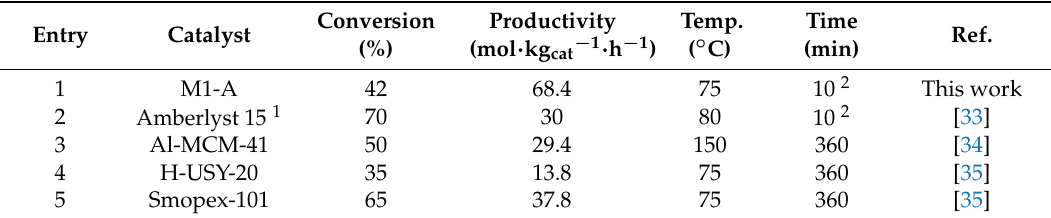
Table 4. Comparison of acetic acid esterification with n-butanol in flow (entries 1–2) and batch (entries 3–5)